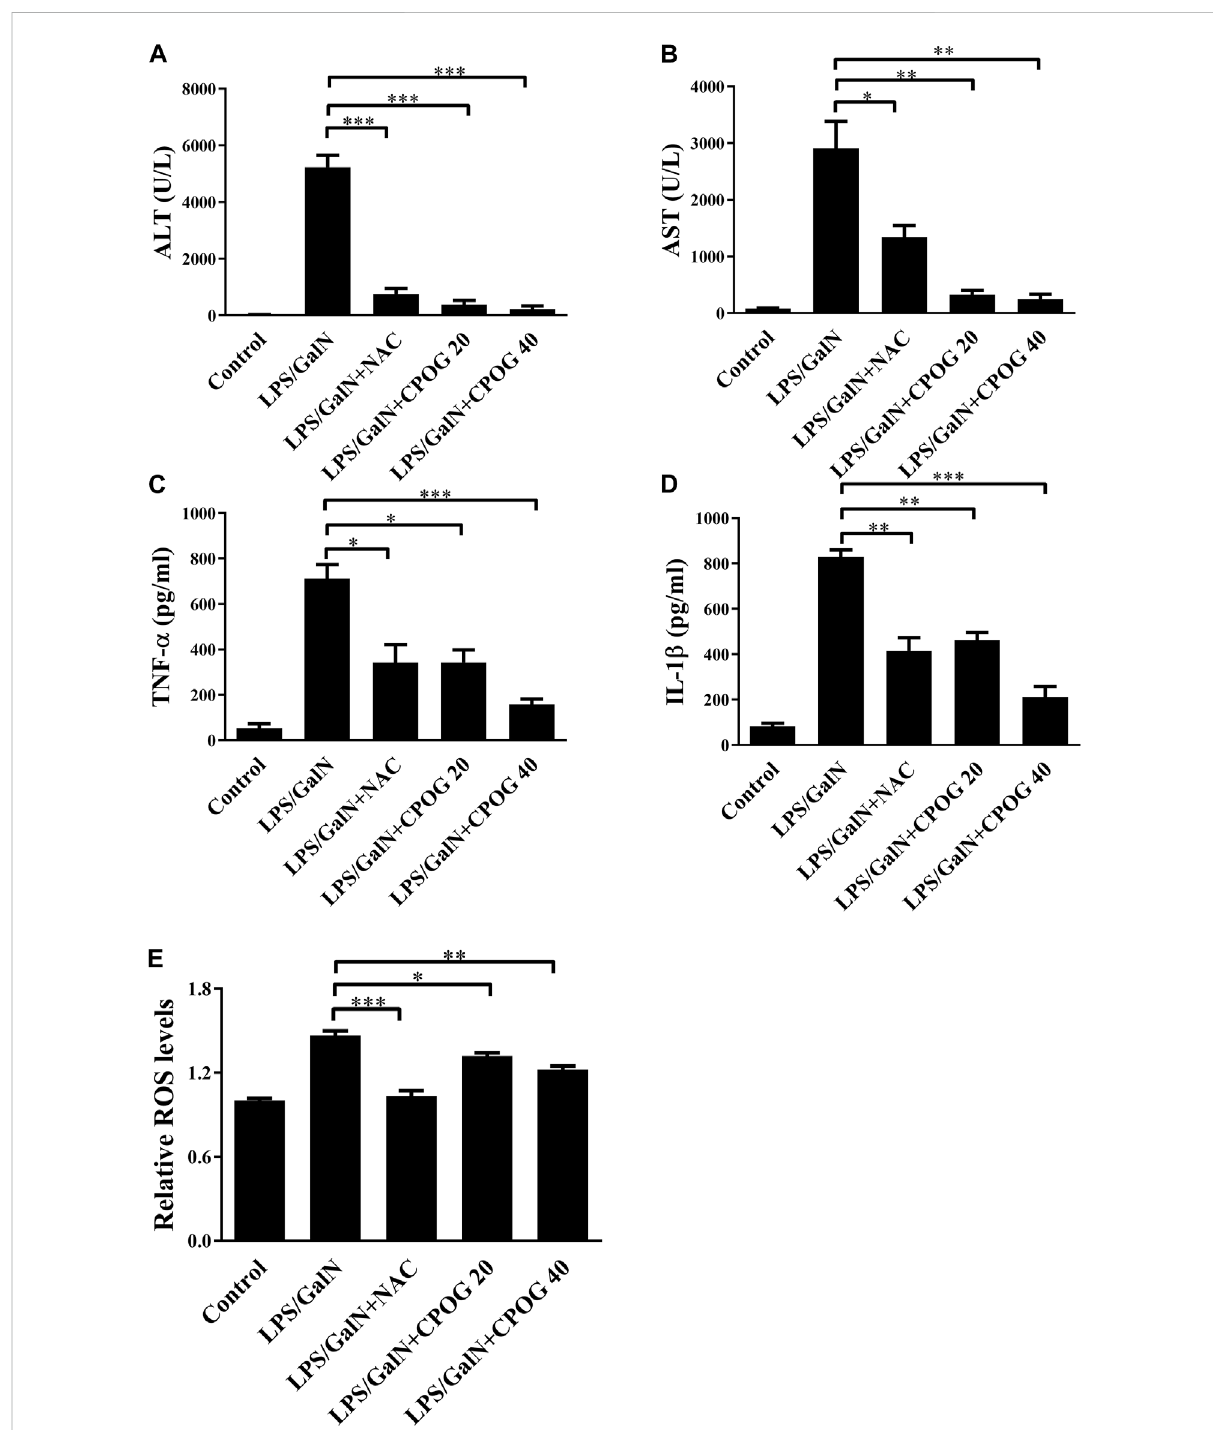
FIGURE 2 CPOGattenuatedin fl ammatoryresponseinLPS/D-GalN-inducedALFmodel. (A,B) 8 hafter LPS/D-GalN injection,theserum levels ofALTand ASTweredetected. (C,D) SerumlevelsofTNF- α andIL-1 β weredetectedbyELISAat8 hafterLPS/D-GalNinjection. (E) ROSlevelsinlivertissuewere determinedbyCM-H2DCFDAat8 hafterLPS/D-GalNinjection.Valuesrepresentmean±S.D.Signi fi cancewasdeterminedbyone-wayANOVAtest. Data are representative of three independent experiments. * p < 0.05, ** p < 0.01, *** p <